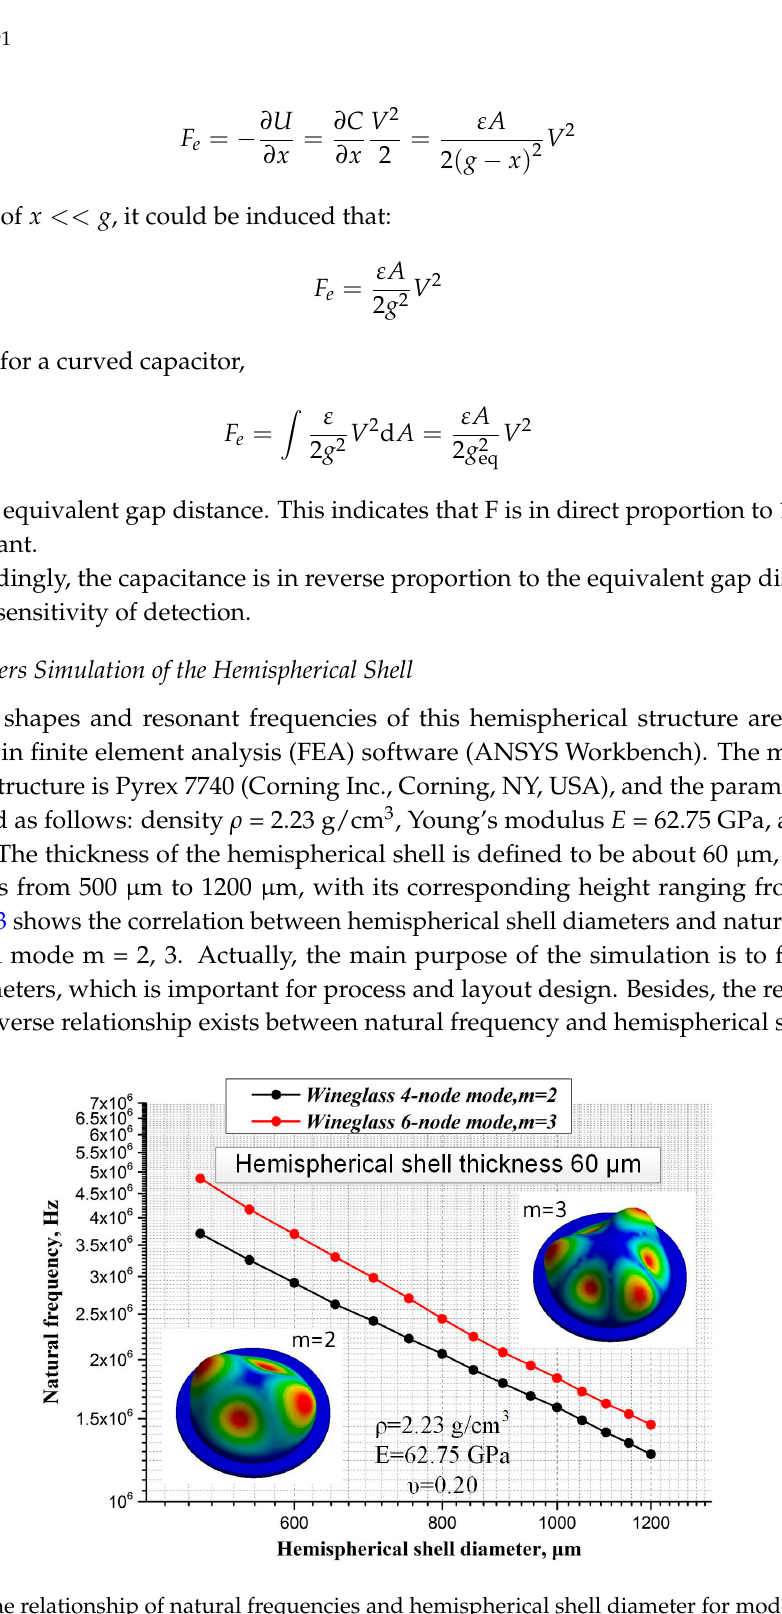
Figure 3. The relationship of natural frequencies and hemispherical shell diameter for mode n = 2, 3.